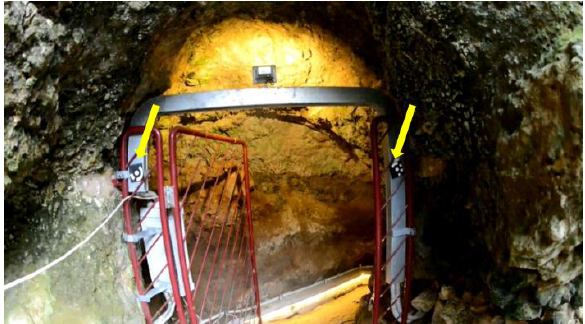
Figure 4. The current entrance of the cave and the targets used as scale